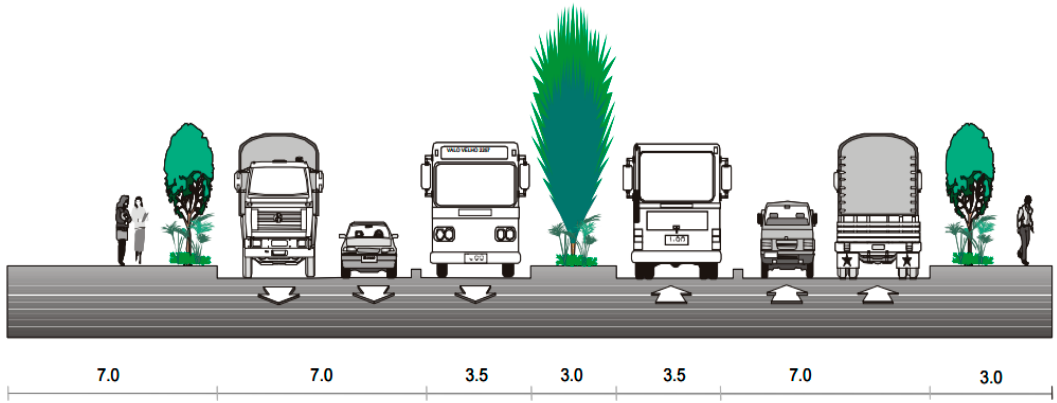
Figure 1. General Bus Rapid Transit (BRT) corridor section, u.m. = meters.